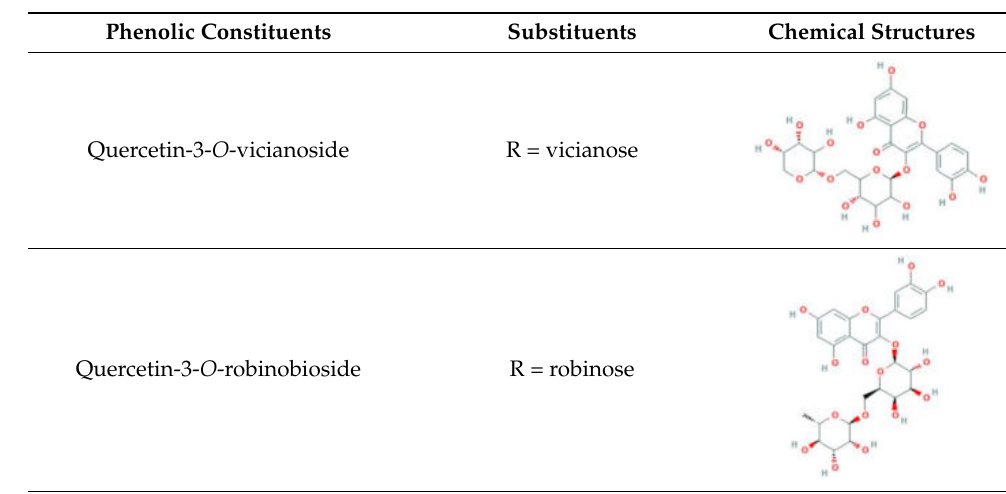
Table 6. Chemical structures of quercetin glycosides